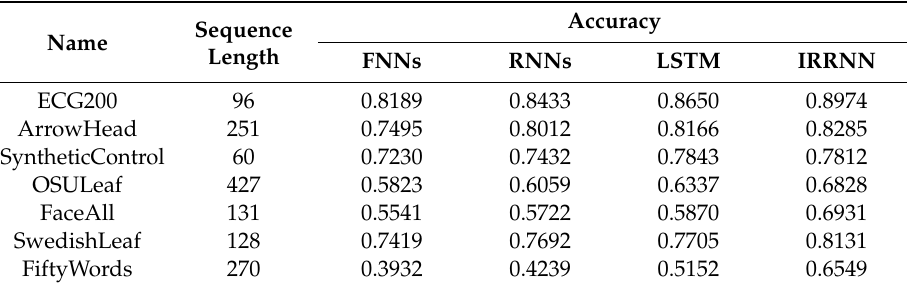
Table 2. Classification accuracy of four algorithms in UCR data